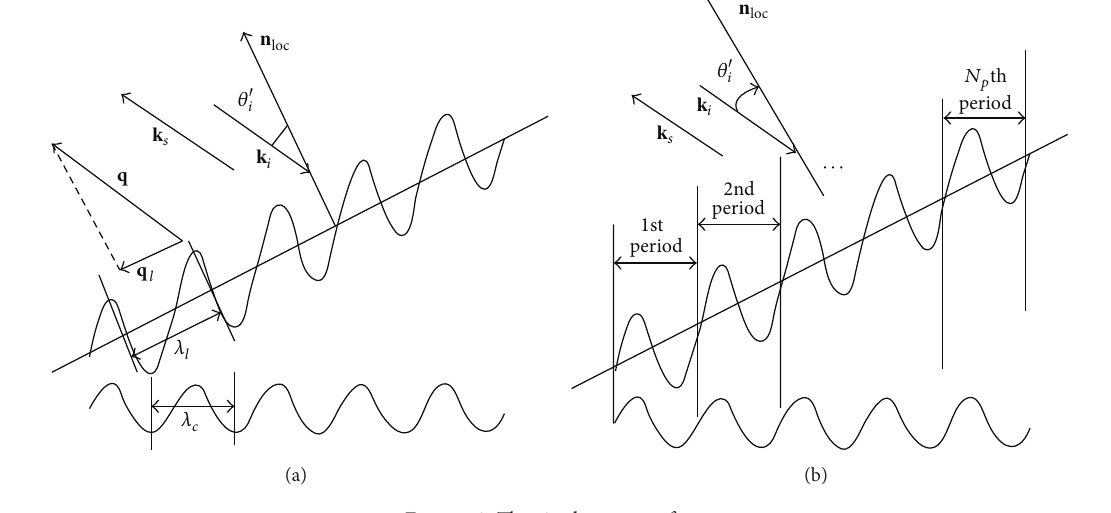
Figure 3: The ripples on one facet.